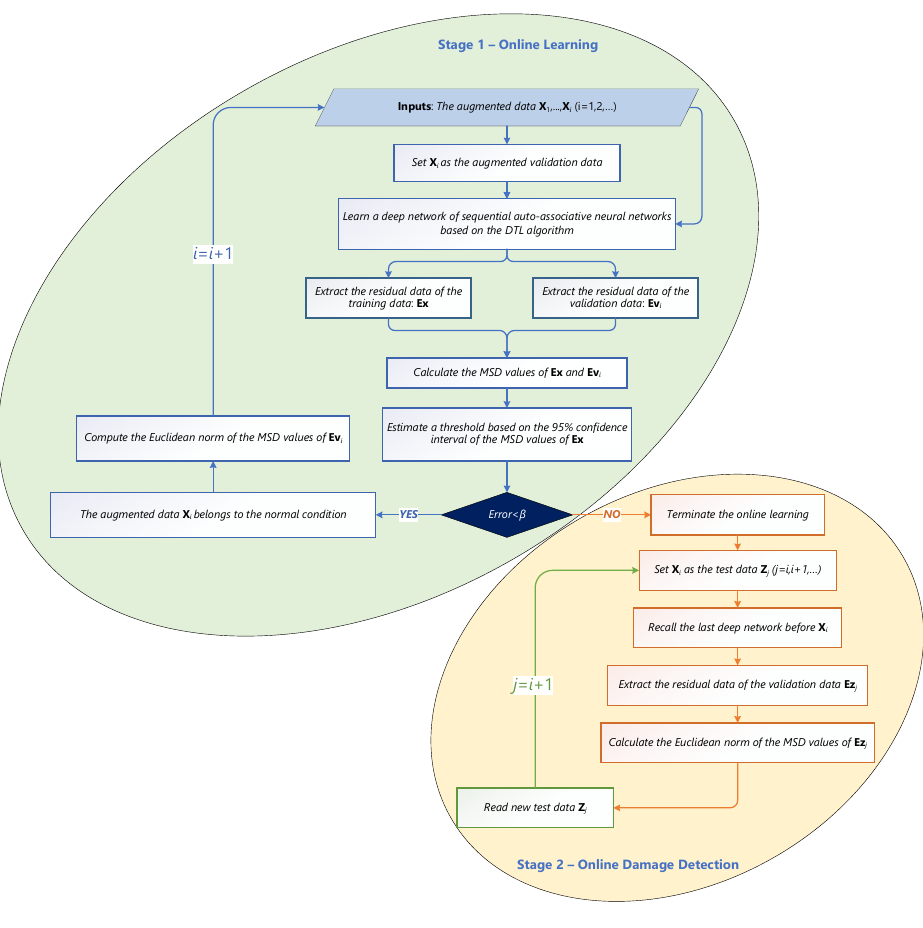
Figure 3. The flowchart of the proposed ODTL method.